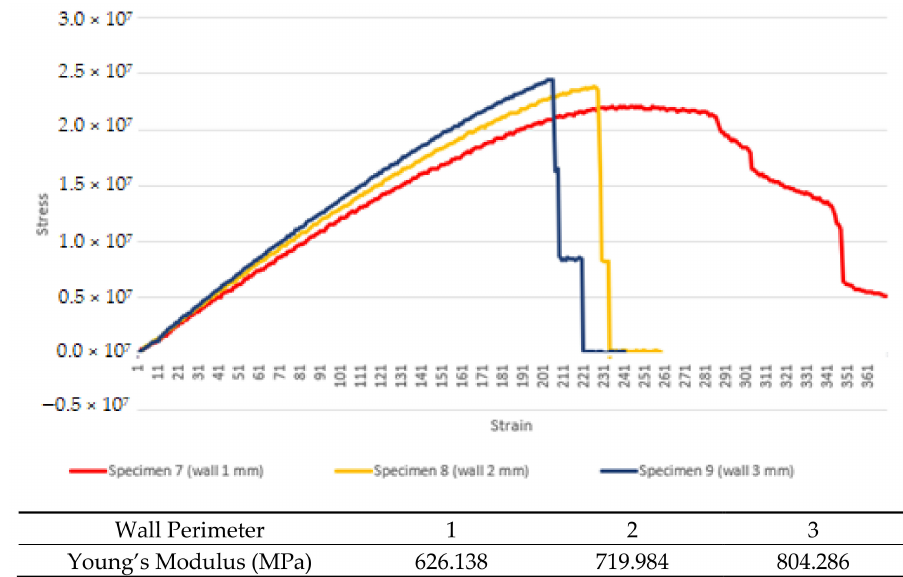
Figure 9. Average experimental stress–strain data for wall perimeter